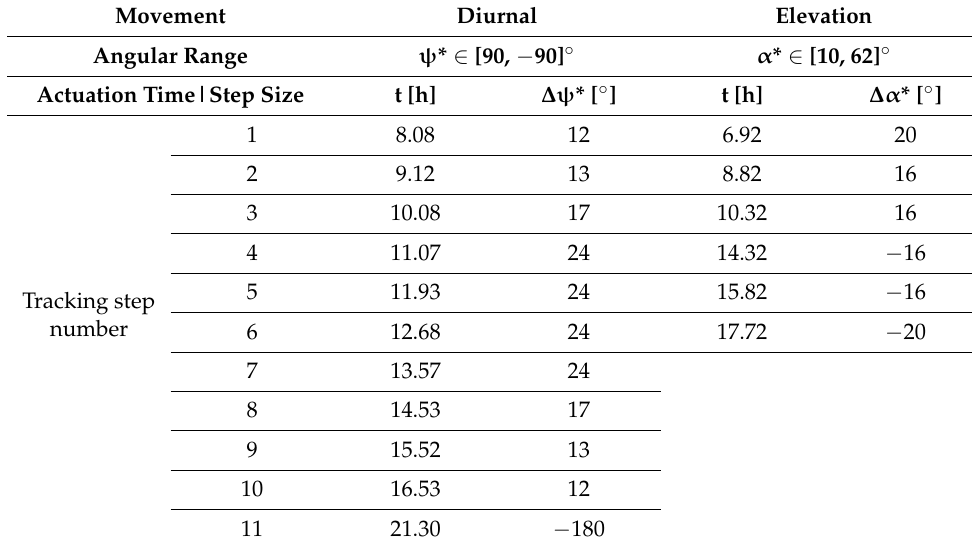
Table 7. Tracking programs “6”/“8”.